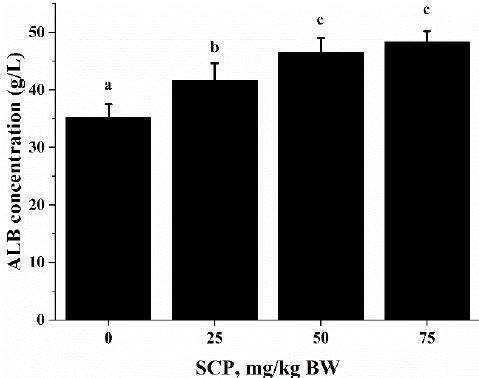
Figure 3. Effect of SCP on ALB concentration in C57BL/6 mice. Mice received daily oral gavage of SCP at 0, 25, 50, or 75 mg/kg body weight for eight weeks. Serum ALB was measured by enzyme linked immunosorbent assay (ELISA) kits. Values are means ± SD, n = 10. For each variable, means in a row without a common letter significantly differ as determined by one-factor ANOVA, p < 0.05.